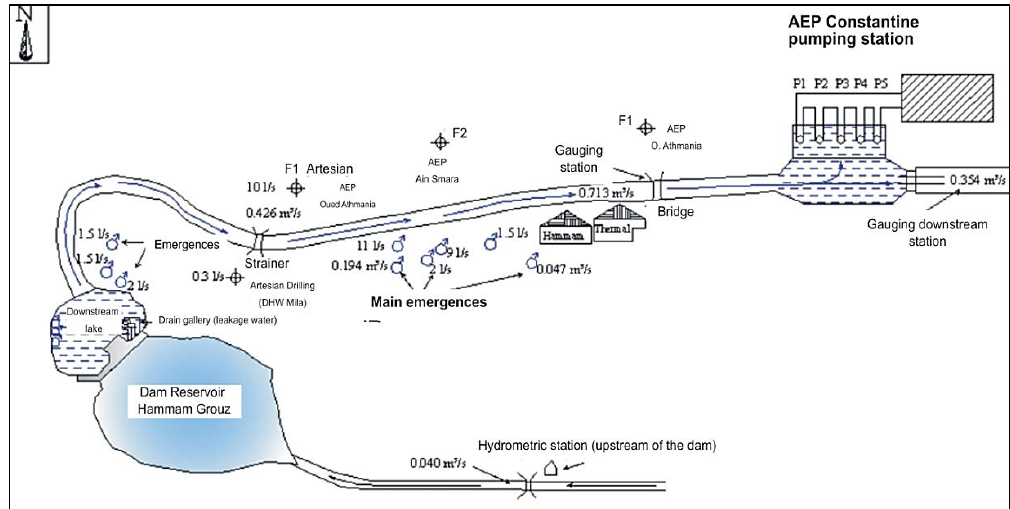
Figure 8. Rough diagram of the resurgences appeared downstream from Hammam Grouz dam